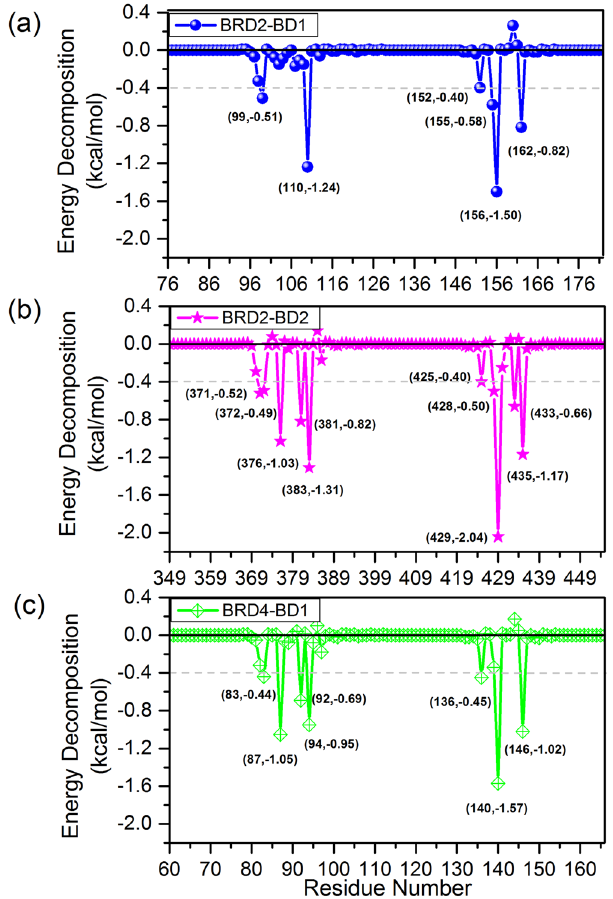
Figure 3. Per-residue energy decomposition in ( a ) BRD2-BD1, ( b ) BRD2-BD2 and ( c ) BRD4-BD1 systems. Residues with contribution more than 0.4 kcal/mol were